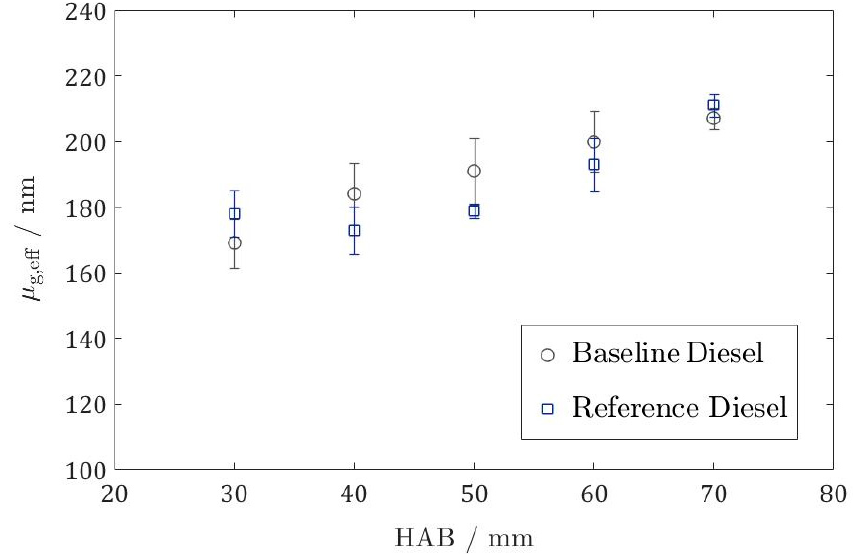
Figure 15. Comparison of the median R g ( µ g,eff ) found at the different HABs investigated for the reference diesel and the baseline diesel.